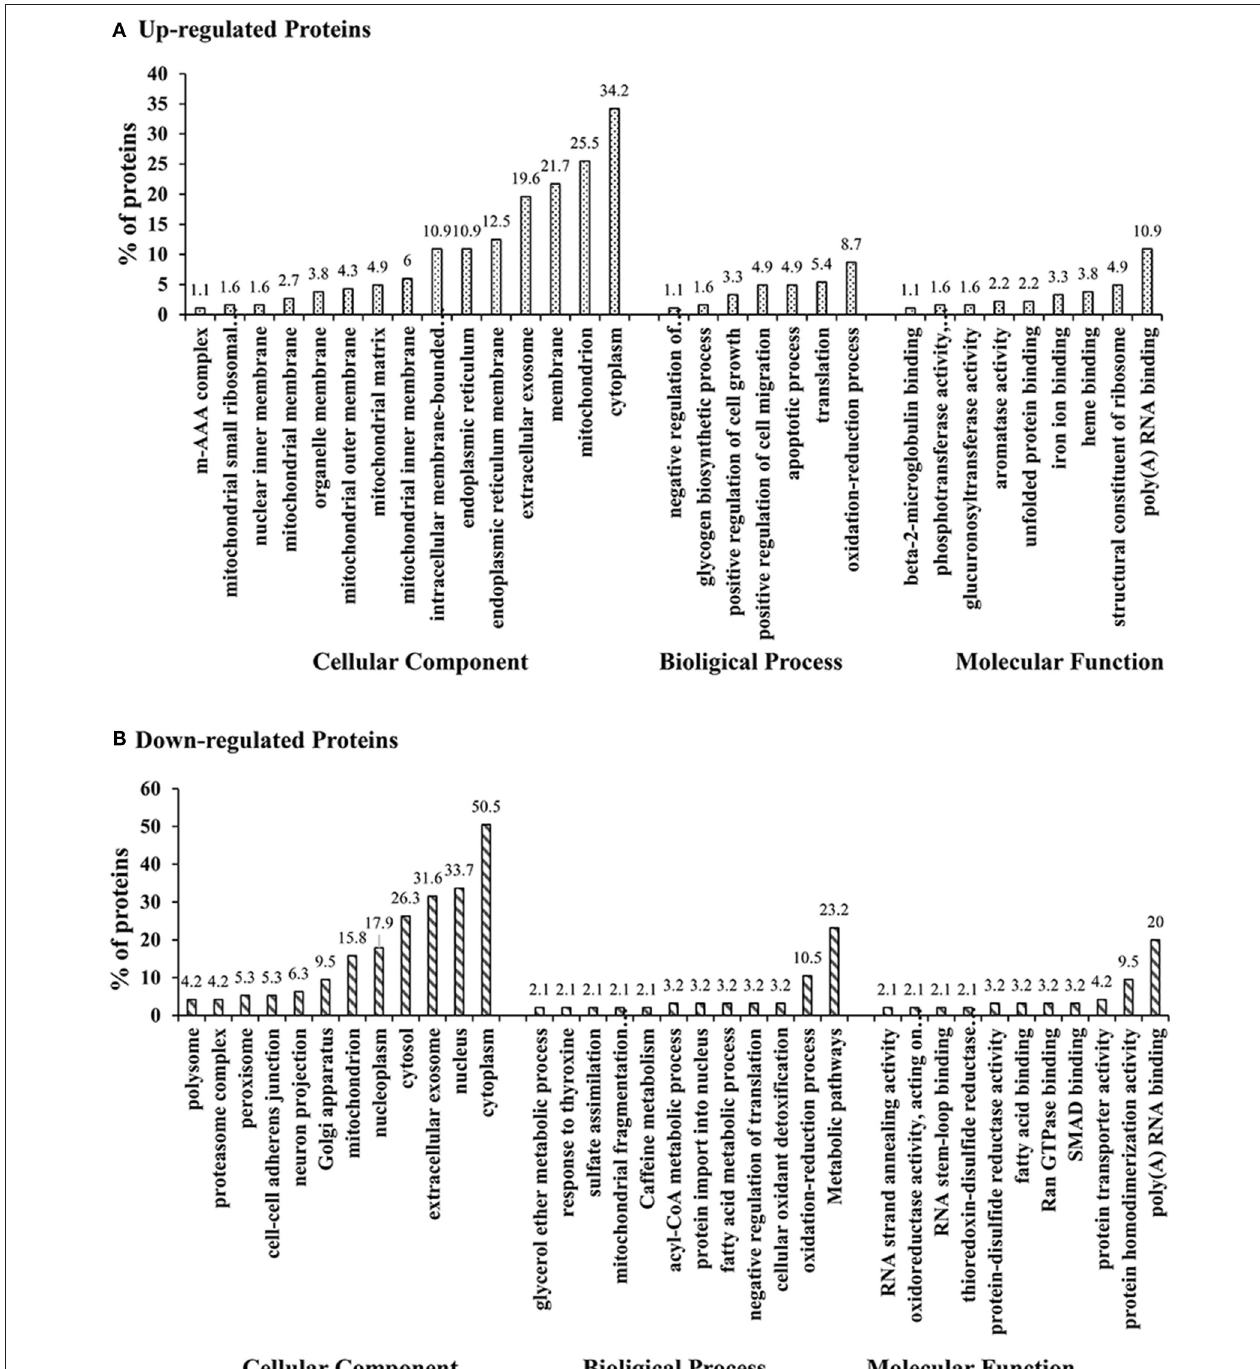
FIGURE 5 | GO classification of up-regulated altered proteins and down-regulated altered proteins between H-ZYCH and DMN-model groups. (A) . GO classification of up-regulated proteins; (B) . GO classification of down-regulated proteins.